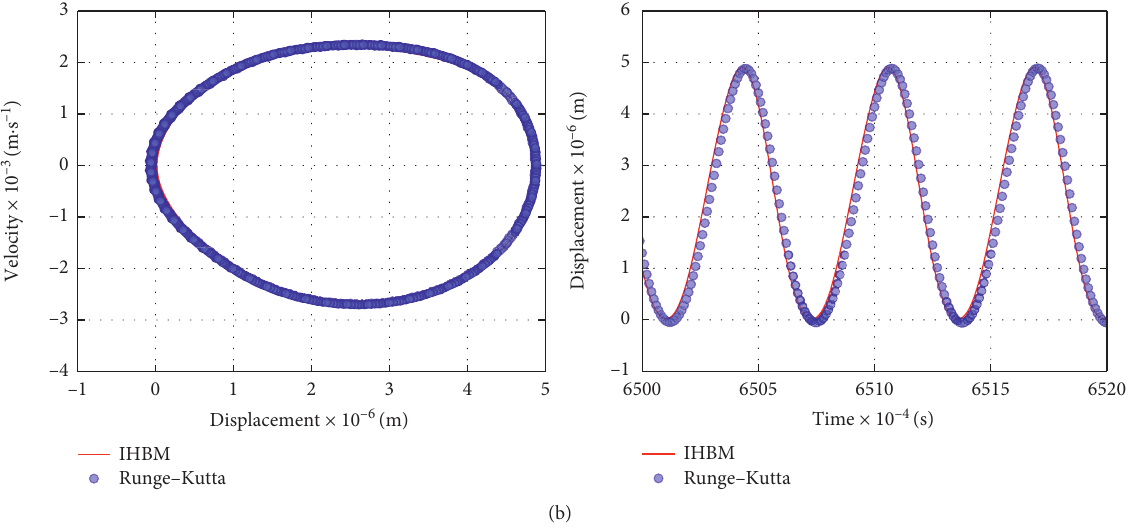
Figure 5: Steady-state response of the gear pair system with Ω � 0.83. (a) No impact and (b) single-side